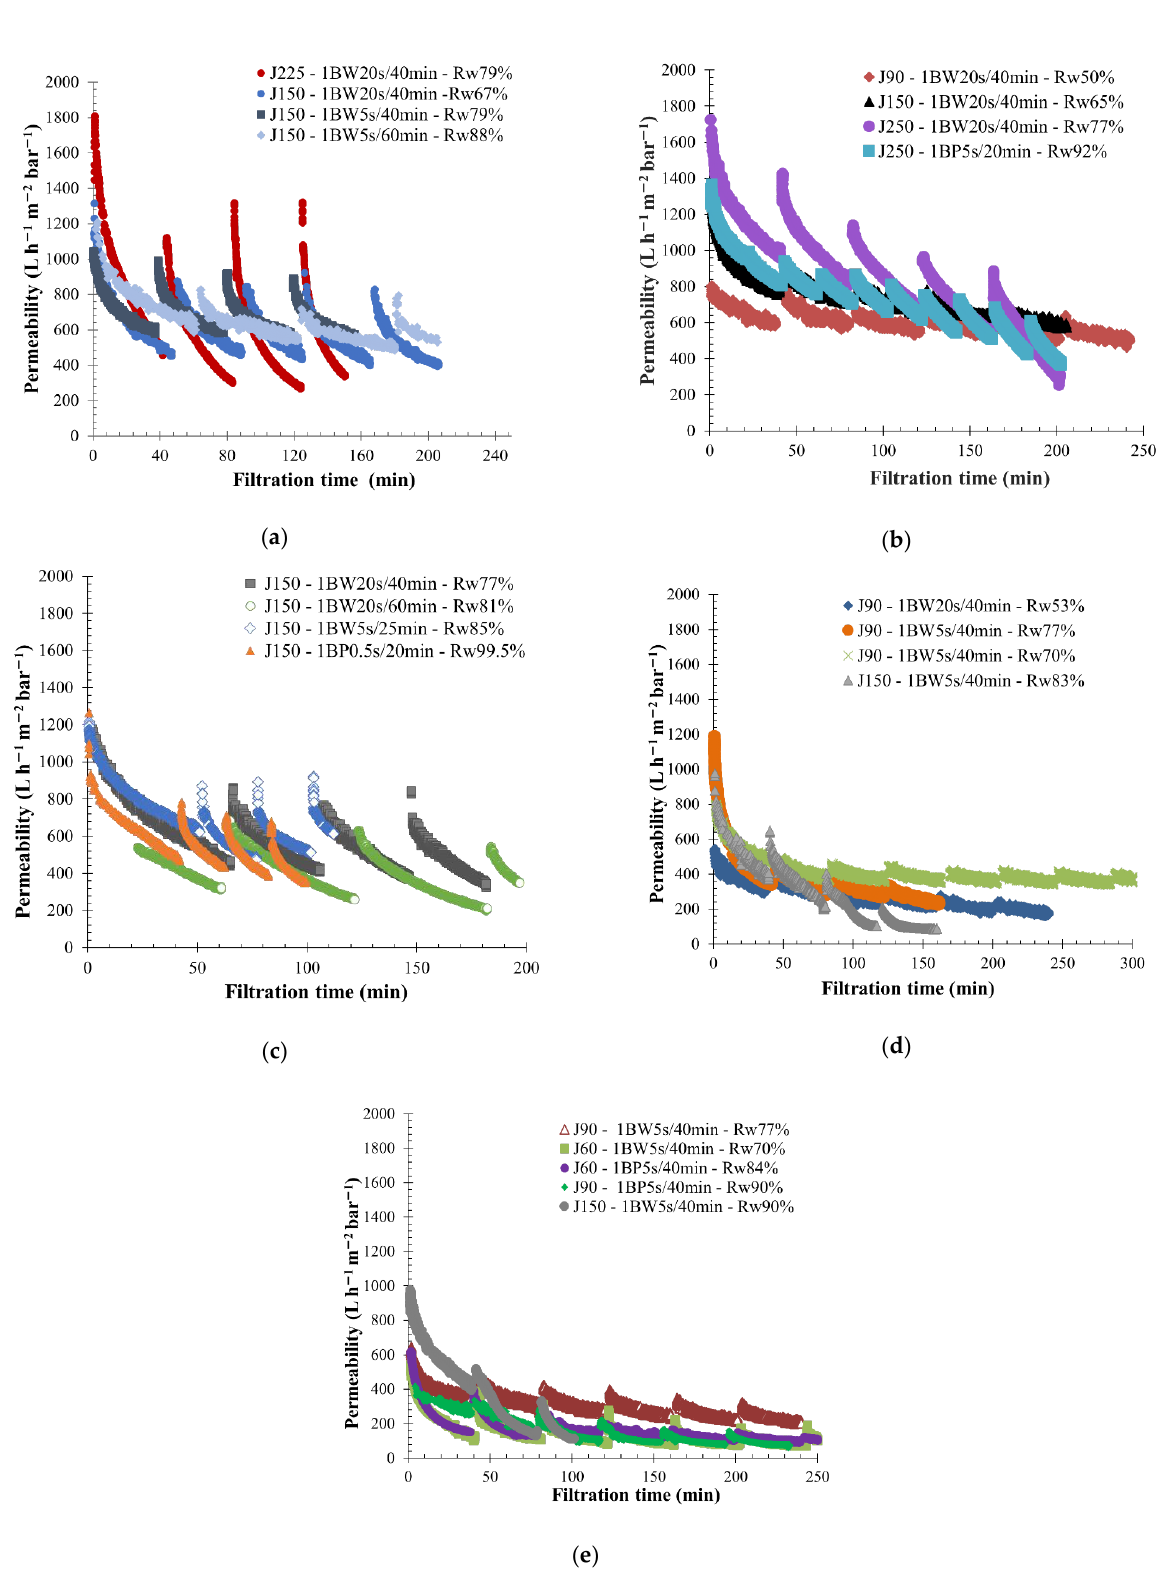
Figure 2. Overview of membrane behavior for all fluid quality tested by variation of the permeability throughout the filtration time. T = 20 °C; SiC membrane 0.33 m 2 . ( a ) APL-SINGAPURA-ME; ( b ) APL VANDA AE; ( c ) APL-SINGAPURA AE; ( d ) APL-VANDA ME; ( e ) CC-KERGUELEN. Jxx is permeate flux at the xx value in L h − 1 m − 2 ; 1BW yy s/zz min where yy is the duration and zz the interval of filtration between two BF (BW or BP as it is mentioned in the legend); and Rw is the total recovery rate applied to the